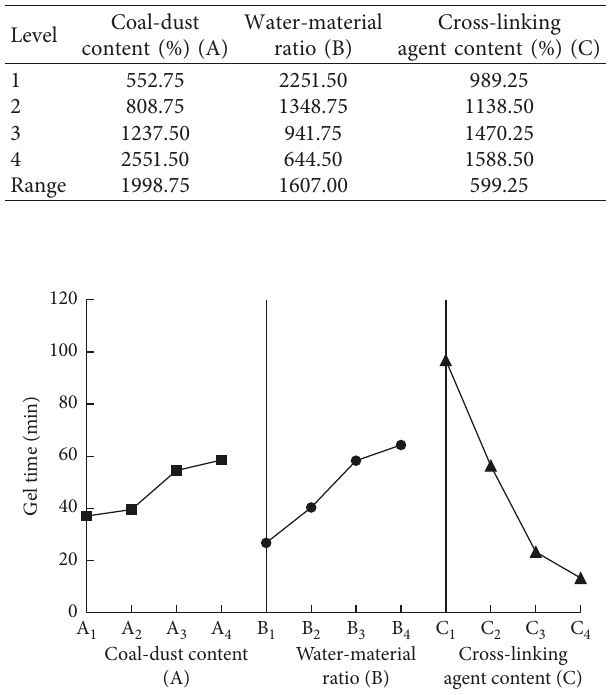
Figure 4: Effective curves of the factors affecting gel